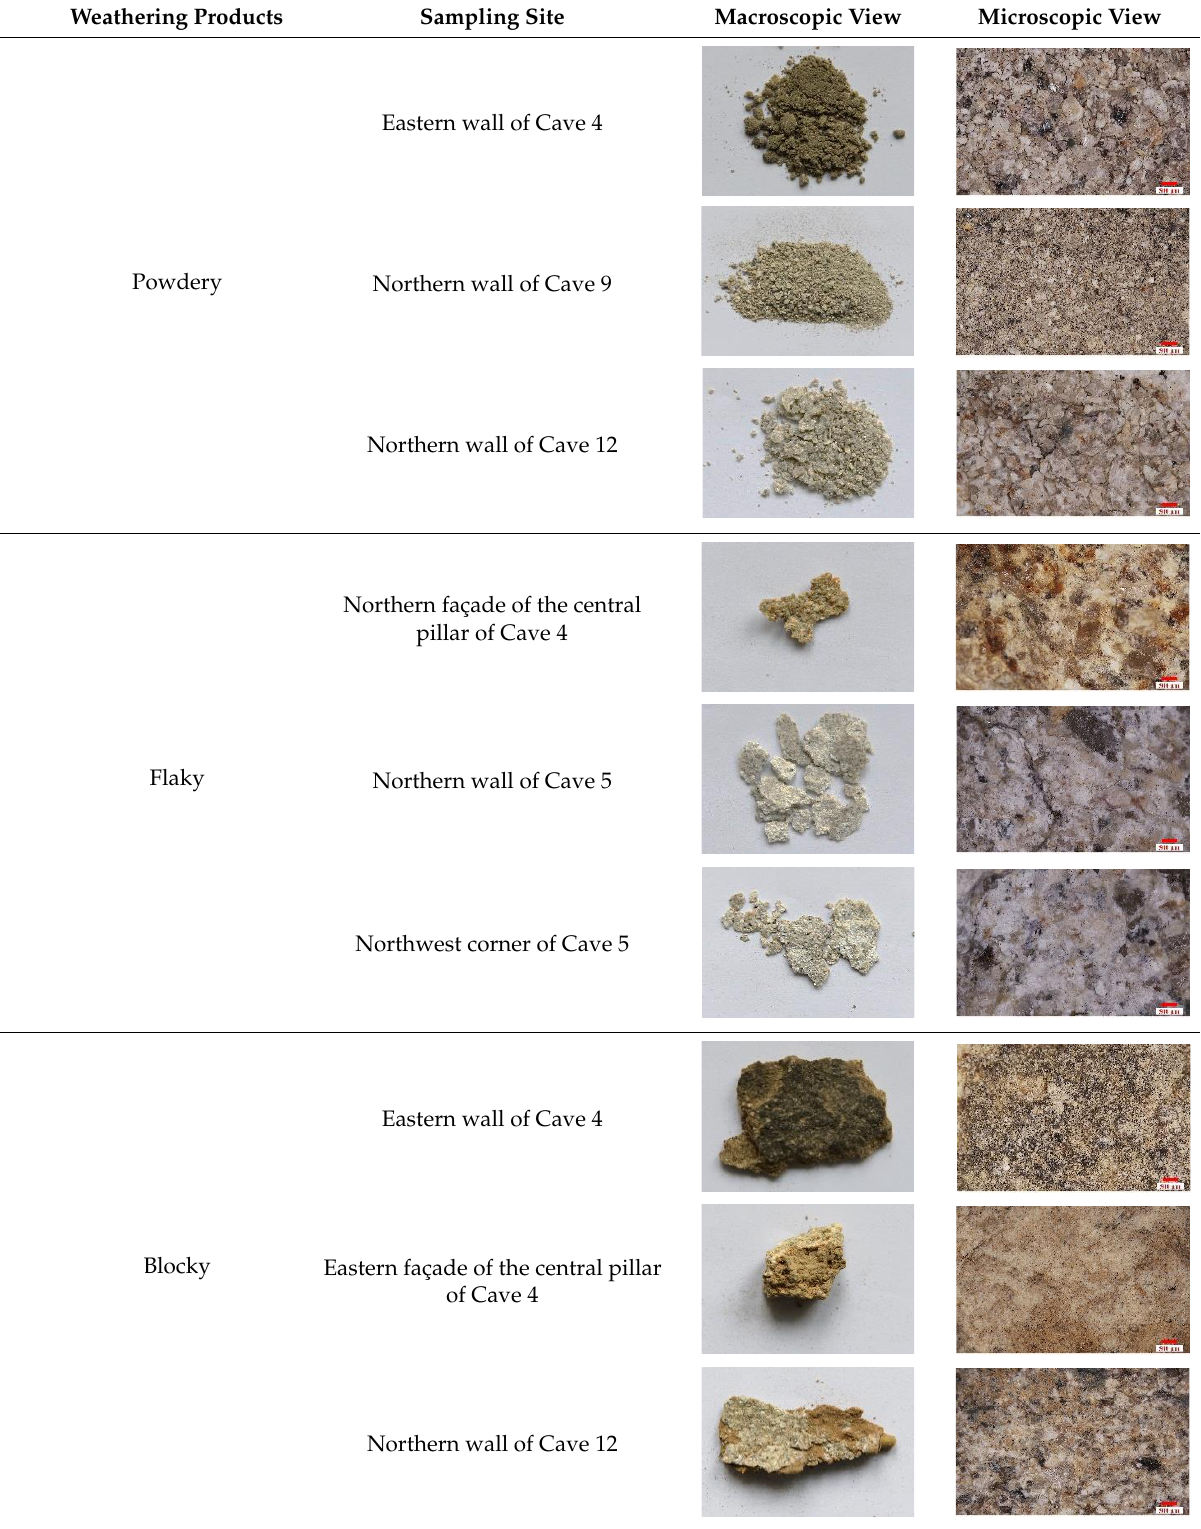
Table 2. Details of sampling in the Yungang Grottoes.